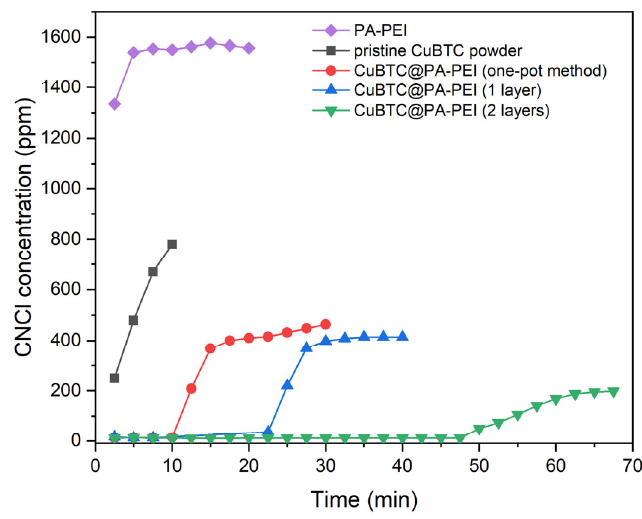
Figure 7. Breakthrough curves of CuBTC@PA-PEI and pristine CuBTC. Table 2. Load rate and elimination abilities of materials.